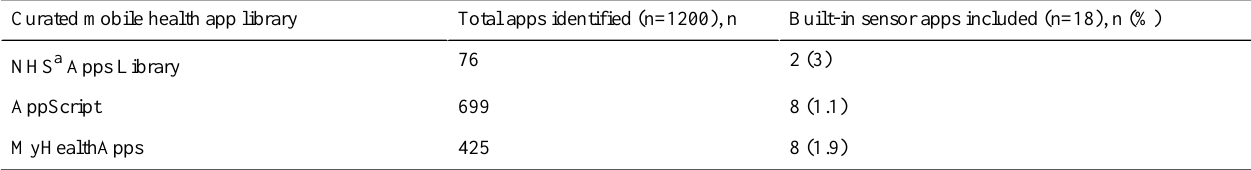
Table 1. Built-in sensor smartphone apps found in surveyed mobile health app libraries.